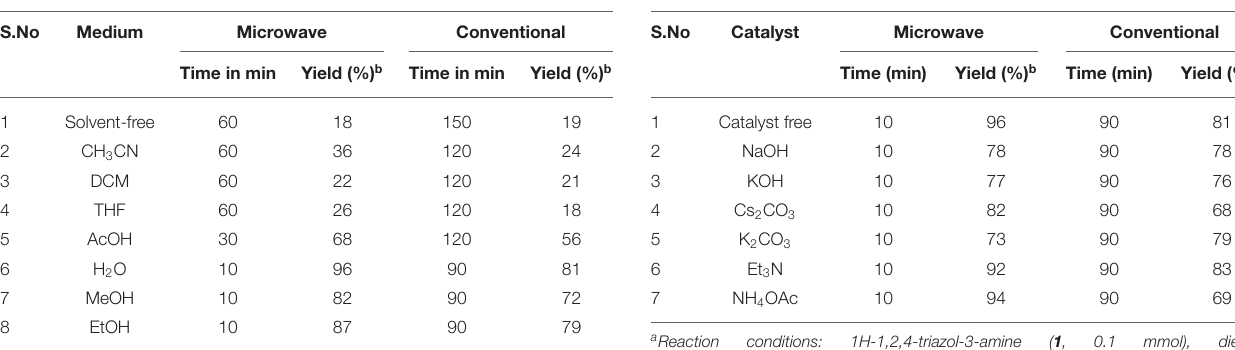
TABLE 2 | Examined the efficiency of catalyst for the 1,2,4-triazol-1,4-dihydropyridine ( 4a ) formation a